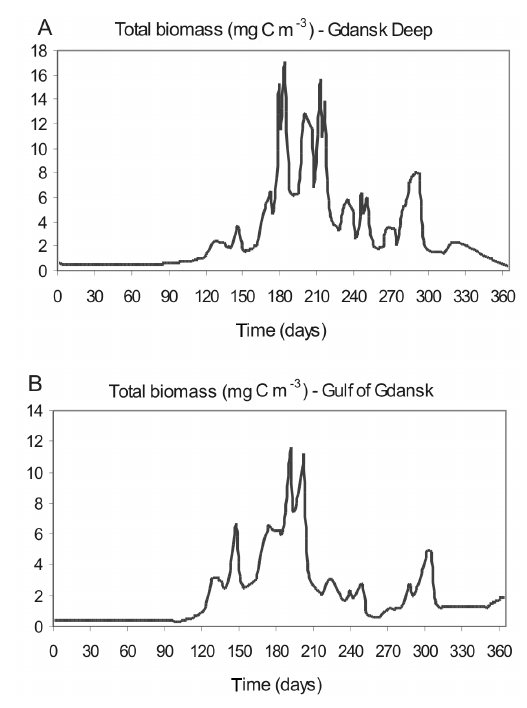
Fig. 5. The observed total biomass of Temora longicornis , averaged in the water column, at stations P1 – Gda ń sk Deep ( A ) and P2 – Gulf of Gda ń sk ( B ) in